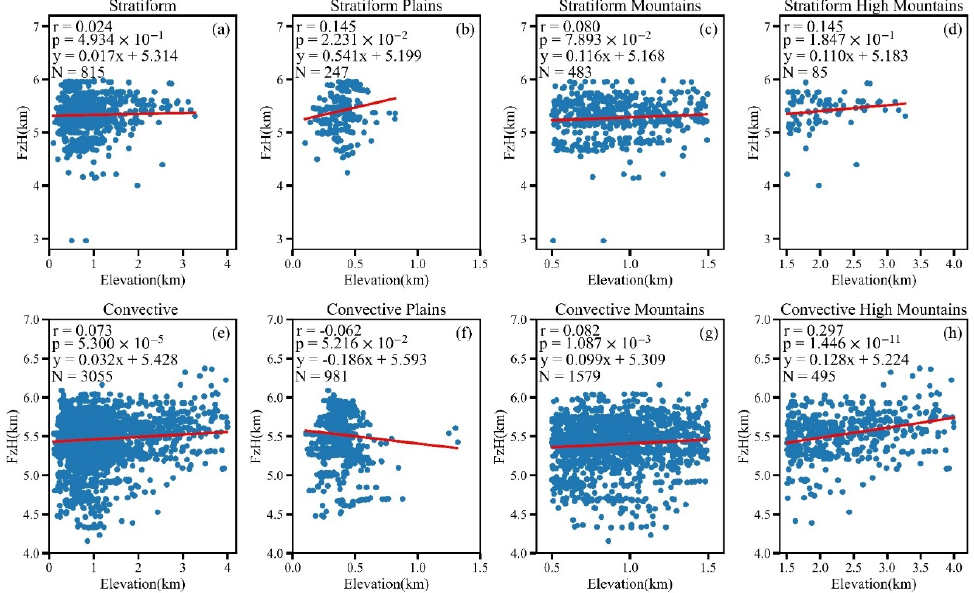
Figure 4. Scatter plots of elevation and FzH of two types of heavy precipitation over ( a , e ) three areas, ( b , f ) plains, ( c , g ) mountains, and ( d , h ) high mountains. r represents Pearson correlation coefficient, p represents significance level, y and red solid lines are the regression equation and N represents sample size.